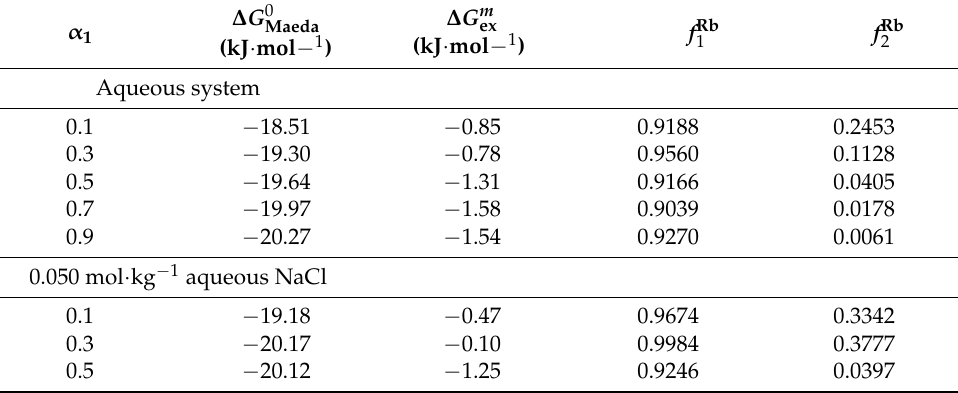
Table 2. Thermodynamic parameters and activity coefficient for IMP + TX-100 mixture in several solvents at 298 K a